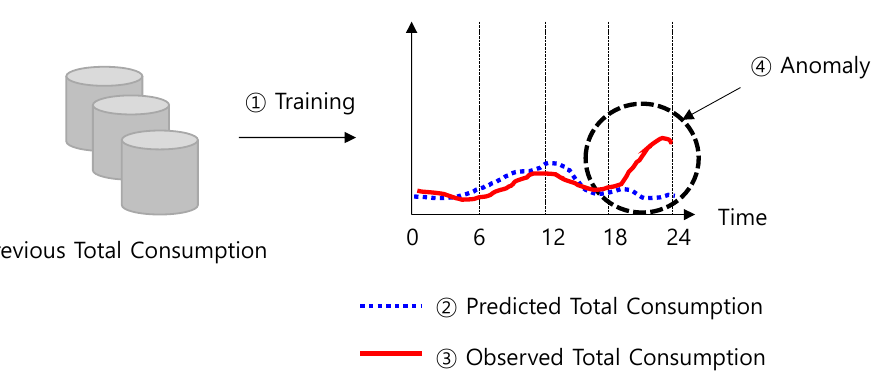
Figure 2. Anomaly detection-based analysis method using machine learning.